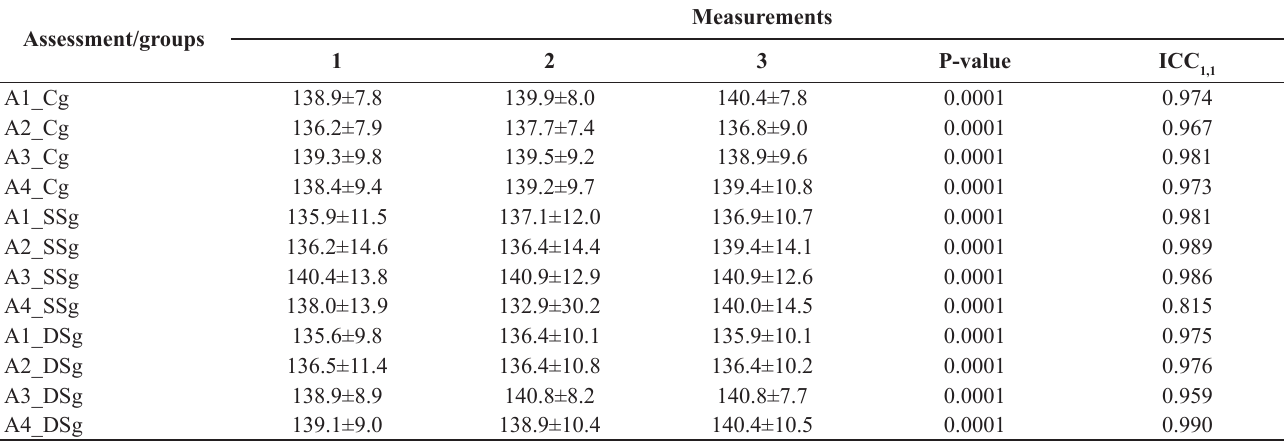
) values for active knee extension range of motion with manual goniometry 1,1